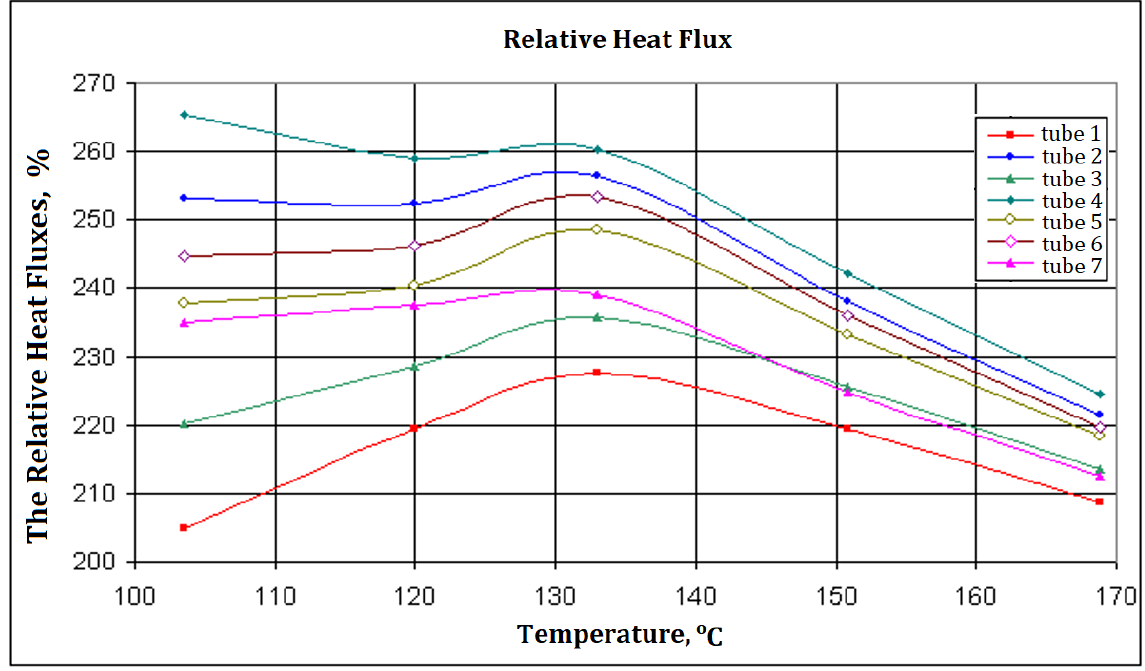
Figure 7. The relative heat fluxes transferred by the tested tubes to the air, compared to the plain tube.